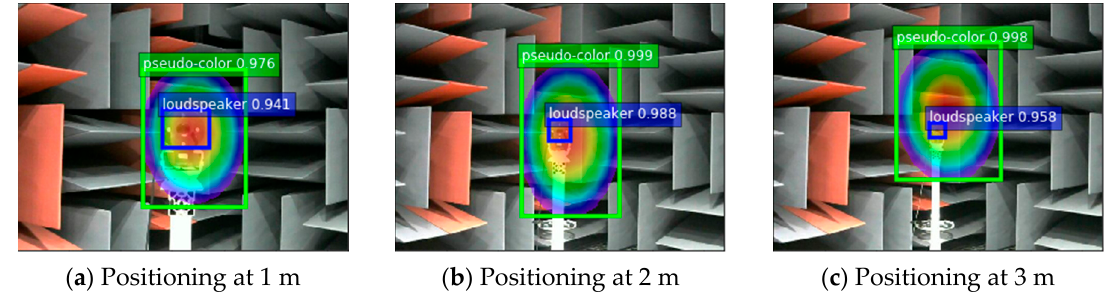
Figure 14. Experimental positioning result.